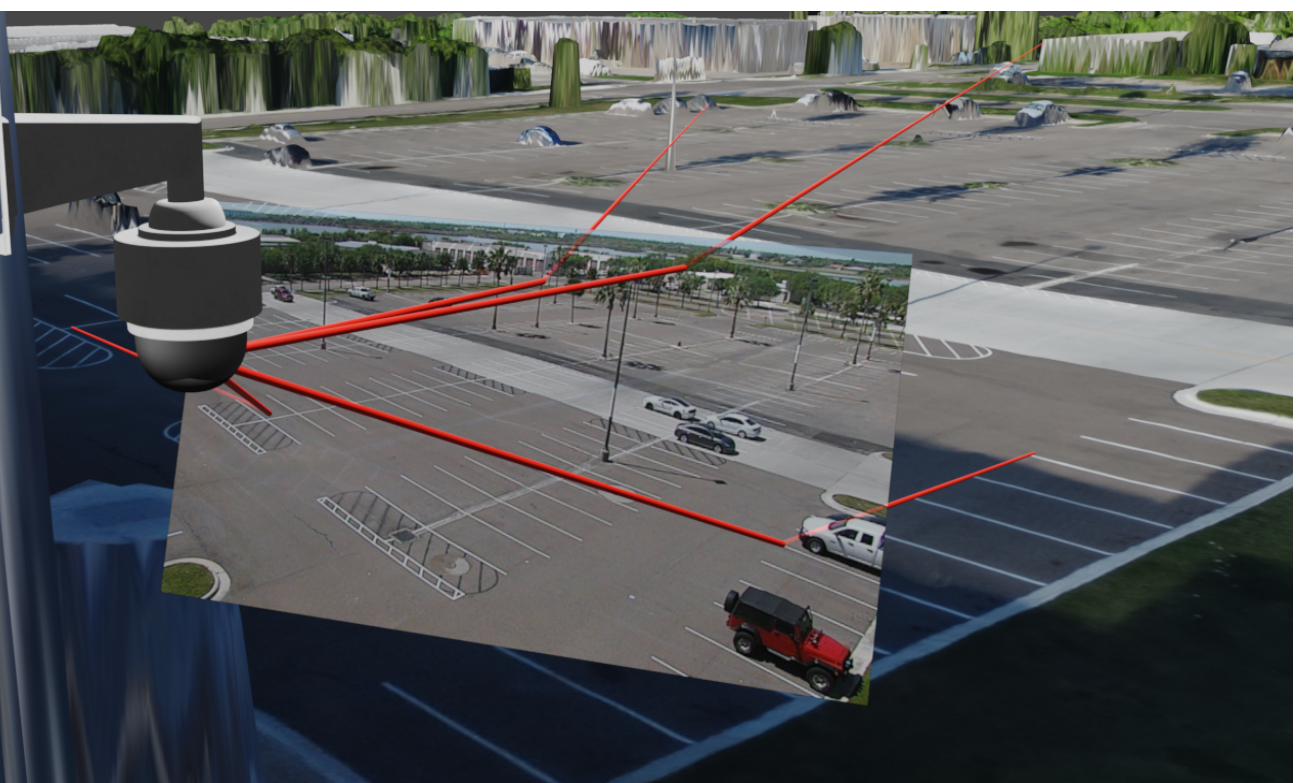
Figure 4. Visualization of the monoplotting principle, and how the arrangement of camera origin, image plane, and world space are determined through the collinearity Equations